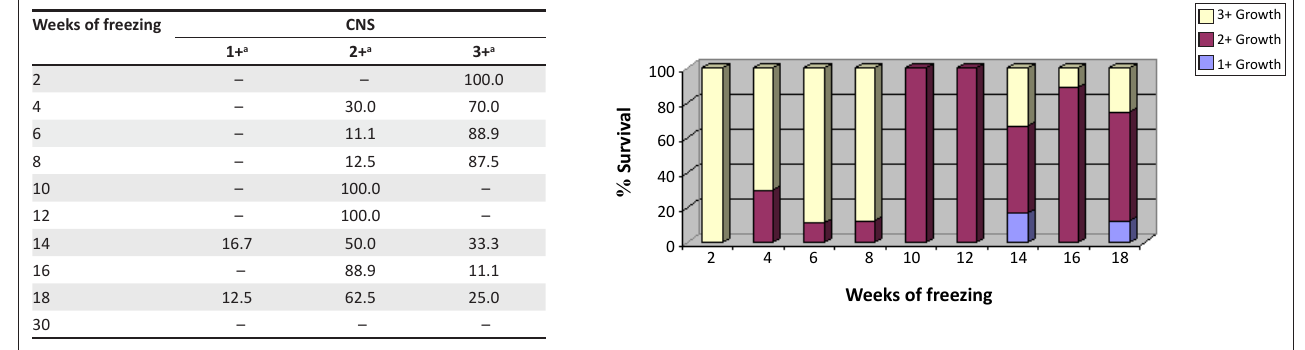
FIGURE 3: Percentage survival and viability of coagulase-negative staphylococci for cryopreserved samples.